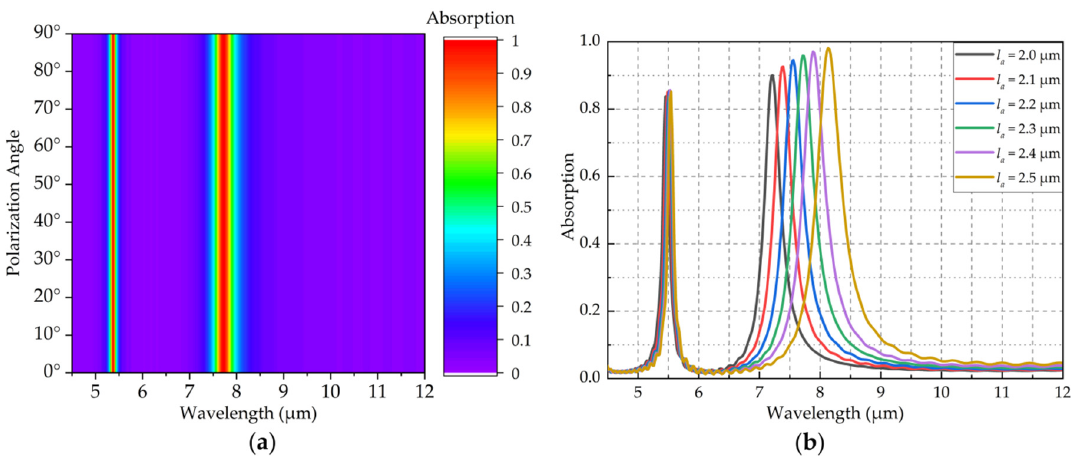
Figure 8. ( a ) Overview and ( b ) top view of the MIM structure with a cross-shape aperture array.